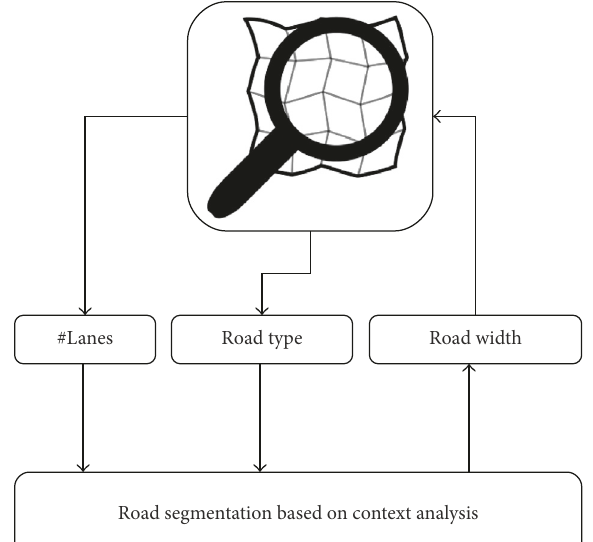
Figure 12: The map prior requires a road width, which is obtained from the road model presented in Section 3.3.5. Furthermore, the generated road model uses the number of lanes and the type of the road from the map. It is a kind of symbiosis where both functions take benefits from the other.